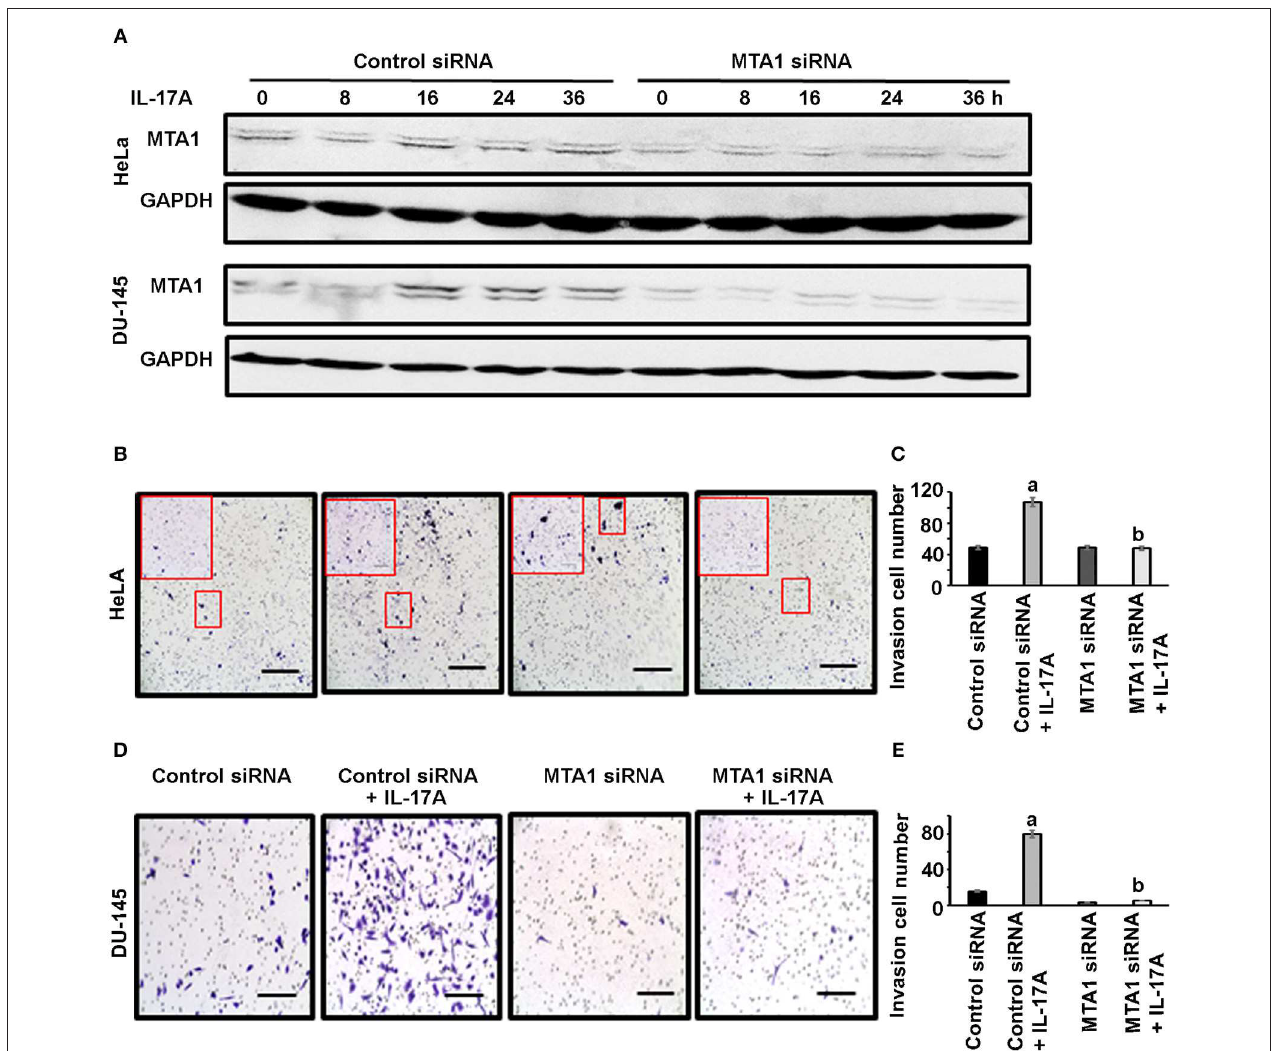
FIGURE 5 | IL-17A acts through MTA1 to promote invasion of human cancer cells. HeLa and DU-145 cells were transfected with either control siRNA or siRNA targeting MTA1. Invasion assays were performed using Matrigel ® -coated invasion chambers. Approximately 2 x10 5 cells were seeded in each upper chamber in serum-free medium without or with 20 ng/ml recombinant human IL-17A in triplicate wells per group, while the lower chamber contained medium with 10% FBS. After 24h, non-invading cells were removed from the upper chamber; the cells invaded through the Matrigel ® -coated porous membrane were fixed with methanol, stained with 0.5% crystal violet, and counted under a microscope. (A) Western blot analyses of MTA1 expression in HeLa and DU-145 cells transfected with control siRNA and MTA1 siRNA, with 20ng/ml recombinant human IL-17A treatment for the indicated time. (B,D) Representative photomicrographs of the porous membrane with stained cells; for HeLa cells, one picture per well under 100 × magnification (scale bar, 400 µ m) was taken, which covered almost the entire porous membrane, and the inserted frame showed the stained cells under 200 × magnification; for DU-145 cells, one representative of 5 regions taken under 200 × magnification (scale bar, 200 µ m) was shown. (C,E) Number of the cells invaded through the porous membrane; data represent mean ± standard deviation (SD, error bars) of 3 independent experiments; a, p < 0.01 between the control siRNA + IL-17A group and the control siRNA group; b, p < 0.01 between the MTA1 siRNA + IL-17A group and the control siRNA + IL-17A group; there was no significant difference between the MTA1 siRNA + IL-17A group and the MTA1 siRNA group ( p > 0.05).